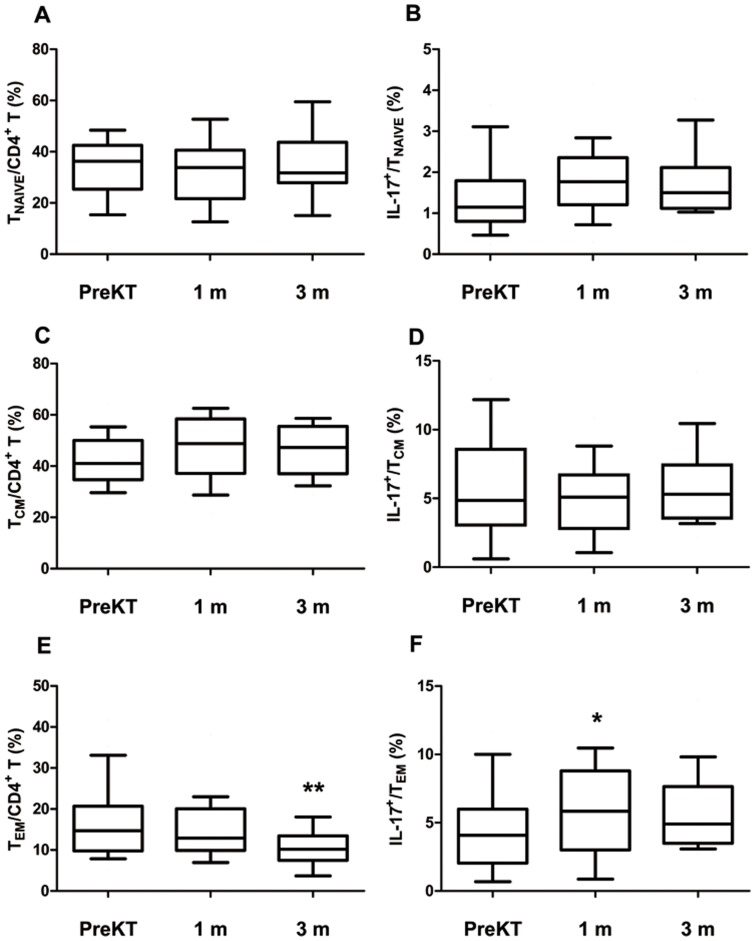
Distribution of Tnaïve, TCM, TEM subpopulations and IL-17+/Tnaïve, IL-17+/TEM and IL-17+/TCM, subpopulations of CD4+T lymphocytes at 1 and 3 month after transplantation compared to before transplantation.PBMC from patients before KT, patients at 1month after KT and patients at 3 month after KT were stimulated for 4 h ex vivo with PMA and ionomycin in the presence of GolgiStop.CD4+ lymphocytes were stained with mAbs to CD45RA and CCR7, which identified three subsets. In addition, analysis of IL-17 in CD4+ T cell subsets by intracellular flow cytometry was done. After surface staining with CD45 and CCR7 mAbs, cells were fixated and permeabilized and intracellular accumulated cytokines were detected with IL-17 mAbs. (A) Tnaïve/CD4+T (CD45RA+CCR7+/CD4+Tcells), (B) IL-17+/Tnaïve, (C) TCM/CD4+ T (CD45RA−CCR7+/CD4+Tcells), (D) IL-17+/TCM
+, (E) TEM/CD4+T (CD45RA−CCR7−/CD4+Tcells), (F) IL-17+/TEM
+. Bars show the means. * P<0.05 vs. PreKT, ** P<0.01 vs. PreKT PreKT, before kidney transplantation; m, month.